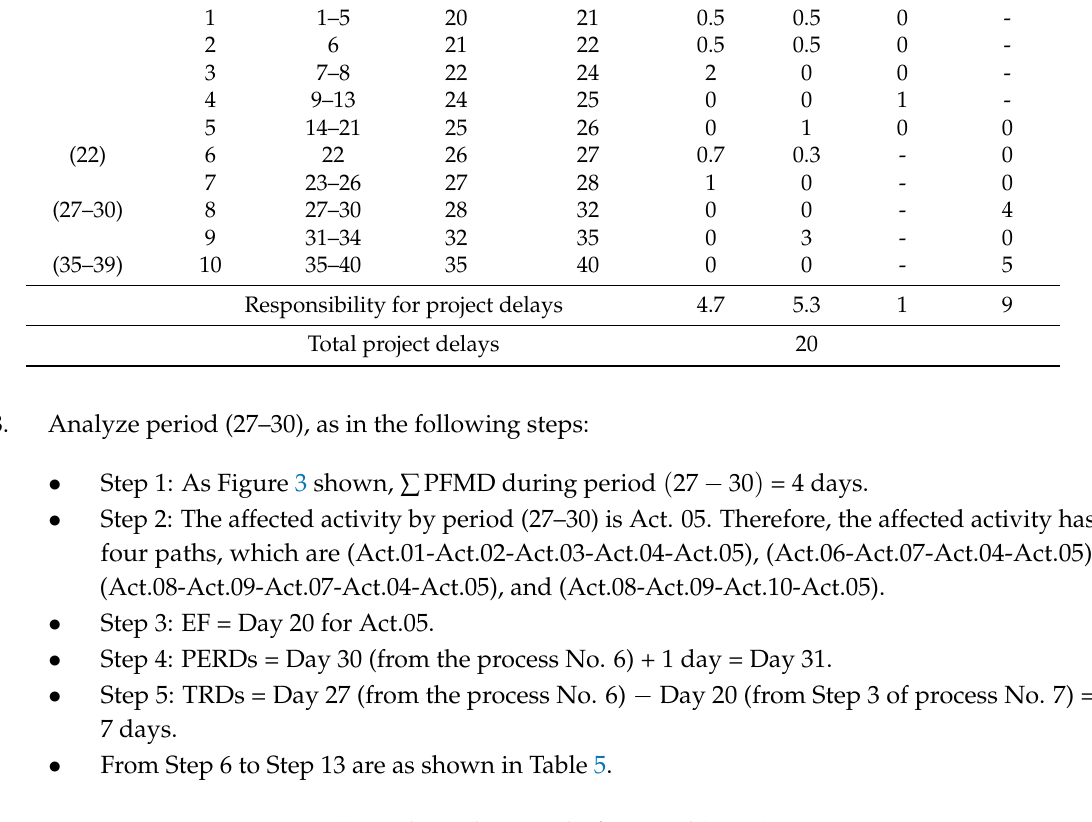
Table 5. The analysis results for period